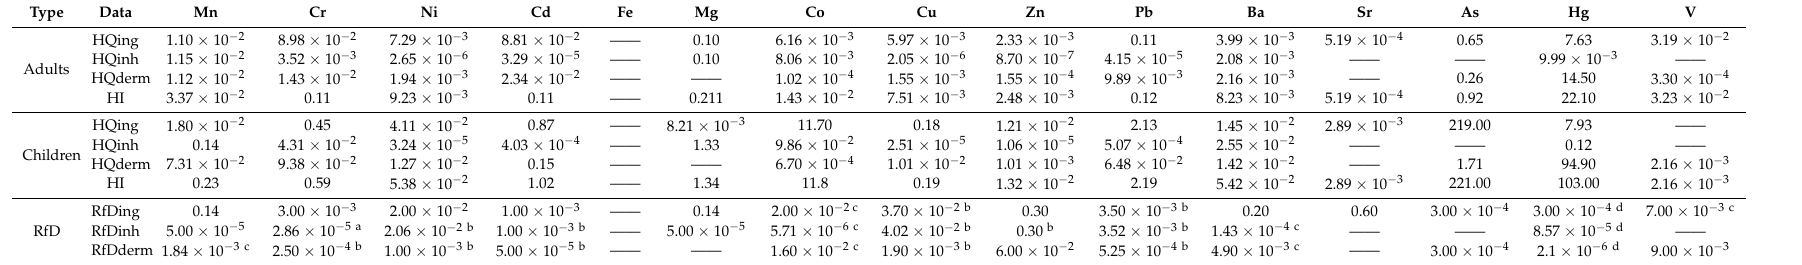
Table 6. Hazard Quotient and Hazard Index for adults and